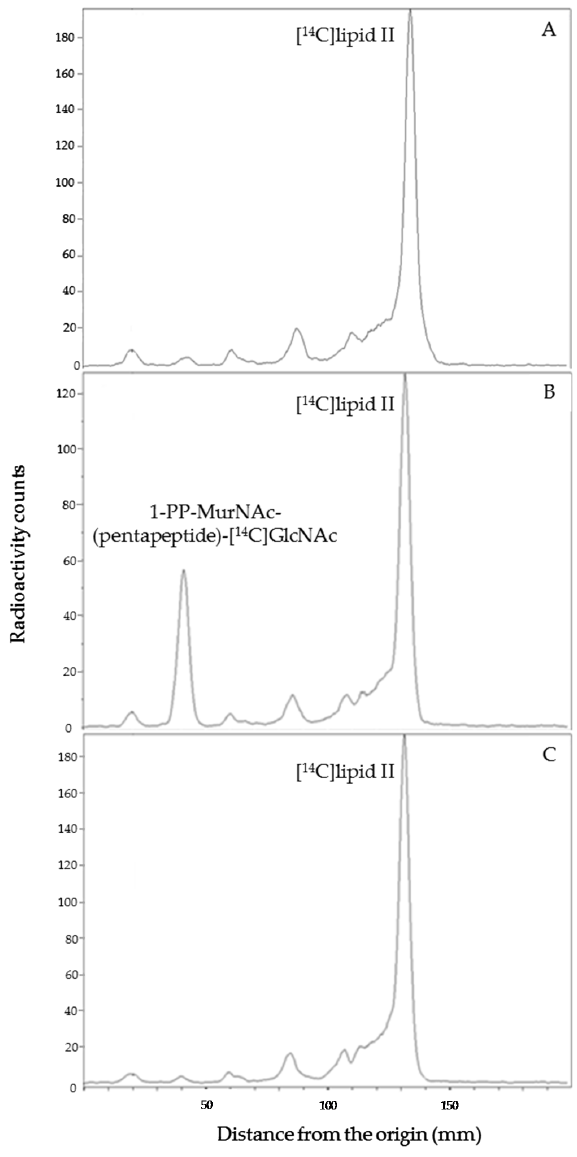
Figure 1. In vitro degradation of lipid II by PcaM1. Conditions that result in ca . 20% hydrolysis of radiolabeled lipid II were used. Purified [ 14 C]lipid II radiolabeled in the GlcNAc moiety (140 Bq) was incubated without ( A ) or with 1.2 μ g of wild ‐ type ( B ) or D222A mutant ( C ) PcaM1. The substrate and reaction product were separated by TLC (solvent system: 1 ‐ propanol/ammonium hydroxide/water; 6:3:1; v/v/v), and the corresponding spots were detected with a radioactivity scanner, as detailed in the text ( R f = 0.7 and 0.3 for lipid II and 1 ‐ PP ‐ MurNAc(pentapeptide) ‐ GlcNAc, respectively).